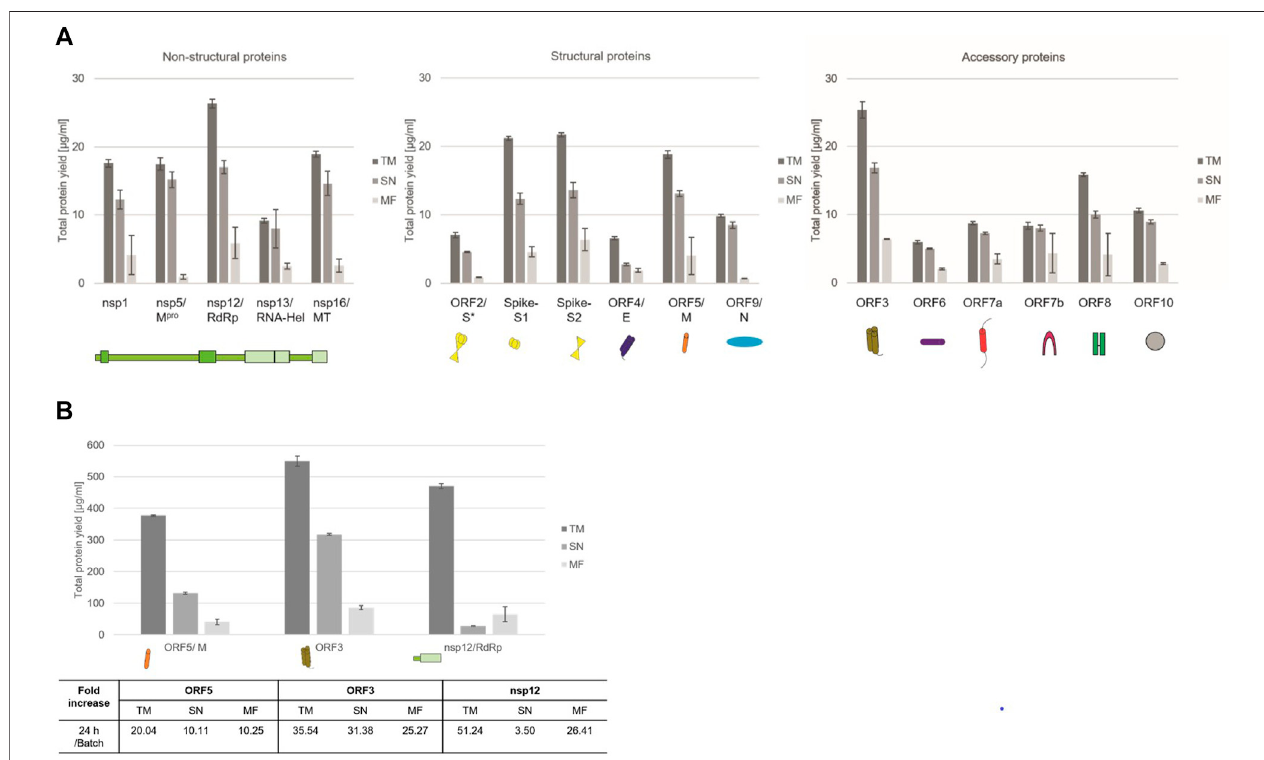
FIGURE2| Quantitativeanalysisofcell-freesynthesizedSARS-CoV-2proteins.ViralproteinsweresynthesizedinCHOlysatein (A) batch-basedreactionand (B) a CECF reaction. The fold increase of total protein yield from a batch reaction to a CECF reaction is shown. Quantitative analysis of 14 C-labeled cell-free synthesized proteins was performed by liquid scintillation counting. Standard deviations were calculated from triplicate analysis. The translation mixture (TM) was separated into the soluble proteins in the supernatant (SN) and the microsomal fraction (MF). The template for the full length Spike protein was based on a PCR-template (*).